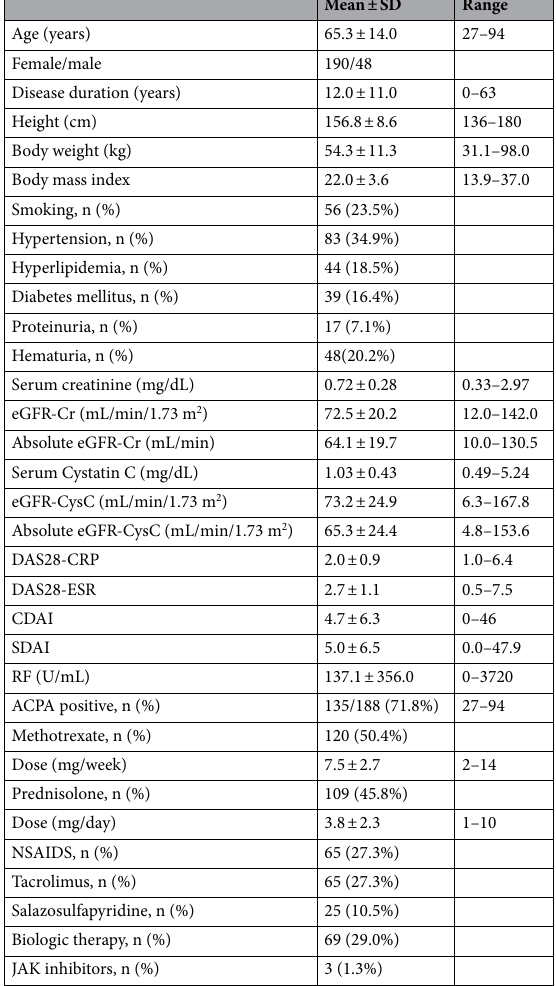
Table 1. Characteristics of the subjects. eGFR-Cr body surface area (BSA)-indexed estimated glomerular filtration rate using creatinine, Absolute eGFR-Cr absolute estimated glomerular filtration rate using creatinine, eGFR-CysC body surface area (BSA)-indexed estimated glomerular rate using cystatin C, Absolute eGFR- CysC absolute estimated glomerular filtration rate using cystatin C, DAS28-CRP disease activity score, using the 28-joint count and C reactive protein, DAS28-ESR disease activity score, using the 28-joint count and erythrocyte sedimentation rate, CDAI clinical disease activity index, SDAI simplified disease activity index, RF rheumatoid factor, ACPA anti-cyclic citrullinated peptide antibody, NSAIDS non-steroidal anti-inflammatory drugs, JAK Inhibitors Janus kinase